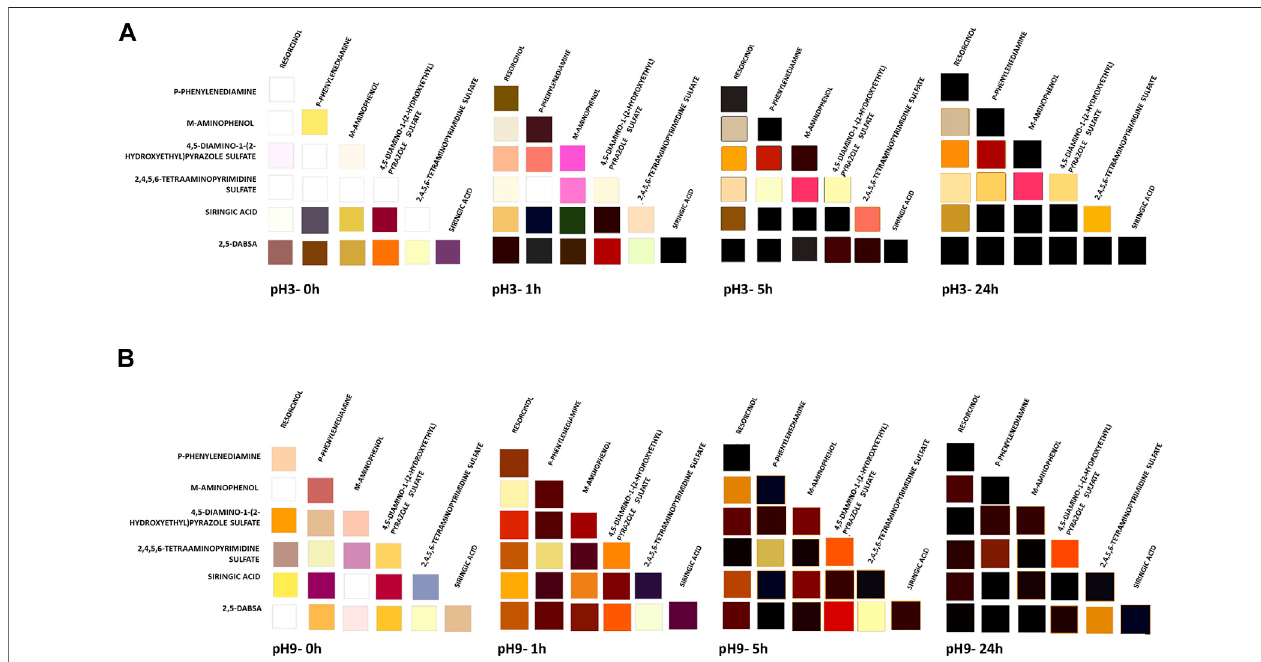
FIGURE 3 | Colors obtained in the enzymatic dyeing at pH 3 (A) and pH 9 (B) of heteromolecular mixture. The solutions were evaluated at different time of laccase incubation (0, 1, 5, and 24 h). The corresponding CIELAB values are reported in Supplementary Table S2 .